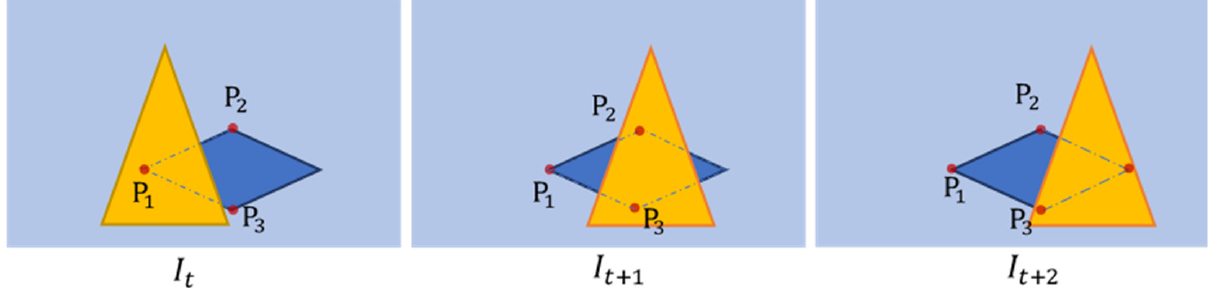
Figure 2. The occlusion problems in moving object detection.